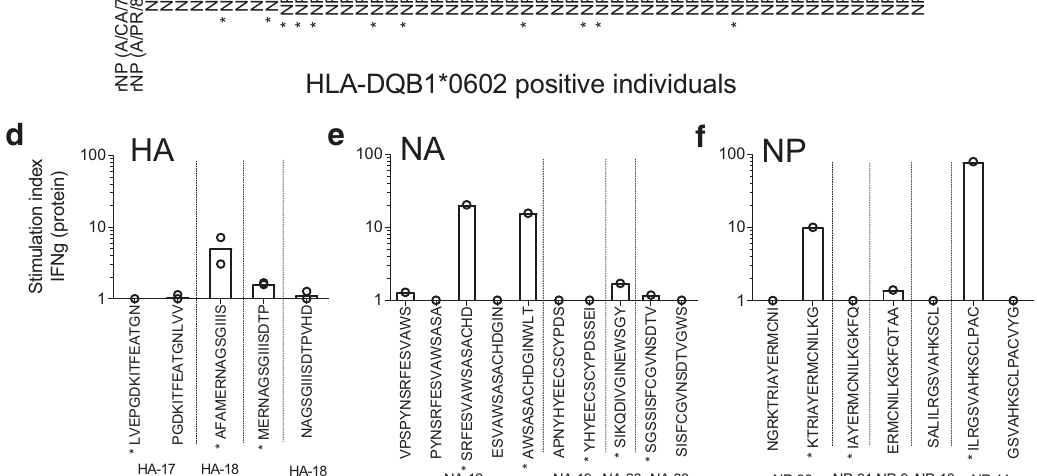
In addition, RNA sequencing of FACS-sorted, NA 175 – 189 - stimulated CD4 + and CD8 + T-cell populations from a single pediatric, Pandemrix-associated NT1 patient (P003) revealed upregulation of IFN- γ , perforin 1, granzyme B, chemokine (C – C motif) ligand 4 , and chemokine (C motif) ligand in CD8 + T-cells, while the gene expression pro fi le of CD4 + T-cells from the same patient was characterized mainly by IFN- γ (Fig. 6; FACS gating